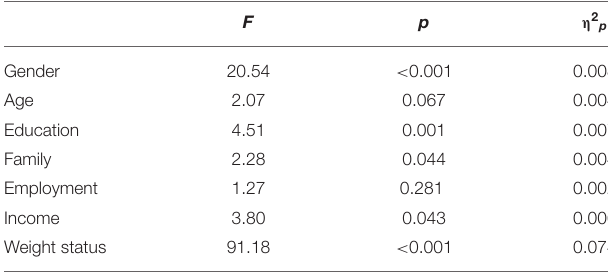
TABLE 6 | ANOVA results for the Self-Regulation of Eating Behavior Questionnaire (Sample